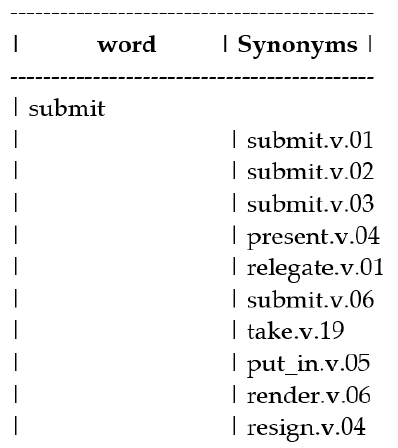
Figure 1. All synonyms of the word “submit”, as extracted from WordNet.